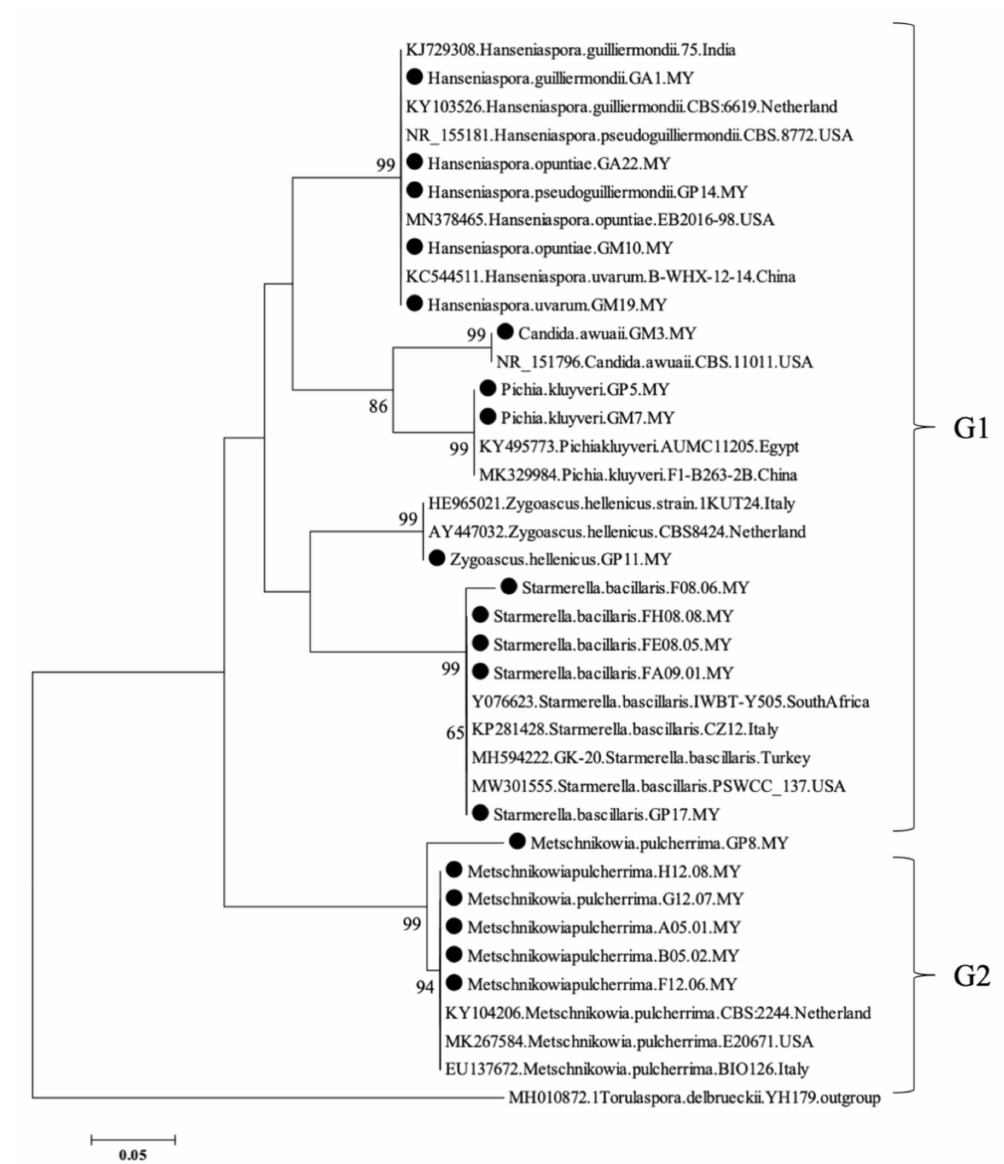
Figure 3. Phylogenetic tree constructed on the sequence alignment of ITS1 and ITS4 regions represent- ing isolated yeasts of grapevine berry and their homologue-related species. Black circles represented the isolated yeast in this study. The phylogenetic tree is inferred from the “Neighbour joining method” and numbers on branches are derived from bootstrap resembled datasets, indicated as percentage of support from 1000 bootstrap replications. Branch lengths represent bootstrap values. Nodes with less than 70% bootstrap support were collapsed. Torulaspora delbrueckii was used as an outgroup species to root the tree. The bar represents 0.05 changes per